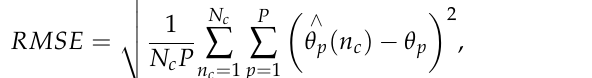
( b ) Figure 4. Resolution of four algorithms with two different SNRs: ( a ) SNR = − 12 dB; ( b ) SNR = 0 dB. Table 2. DOA estimates in Figure 4. SNR ( dB )